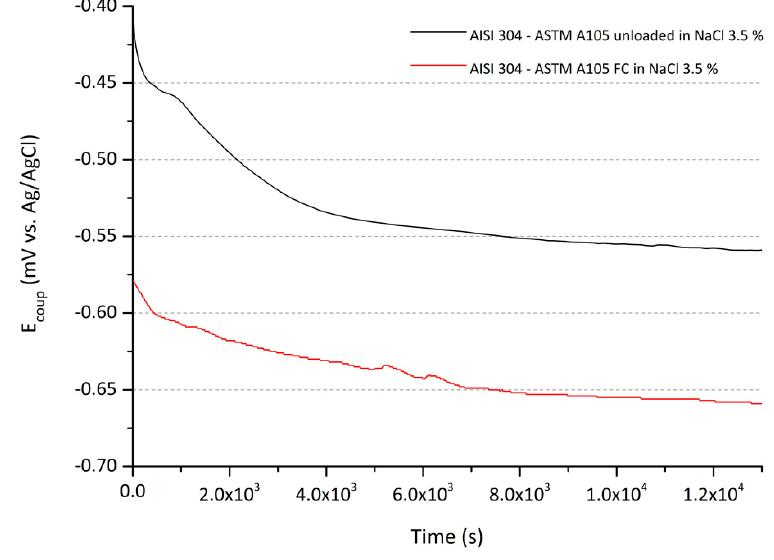
Figure 8. Potential evolution over time of coupled AISI304—ASTM A105 in a 3.5 wt% NaCl solution unloaded sample and on a loaded sample tested to fatigue corrosion at 500 MPa.